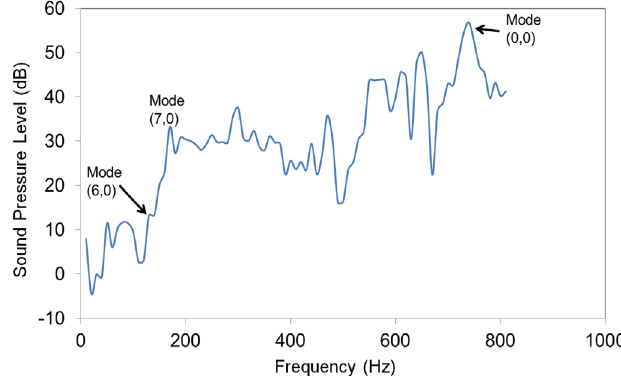
Figure 12. Acoustic response of the multi-layer reactor at a distance of 10